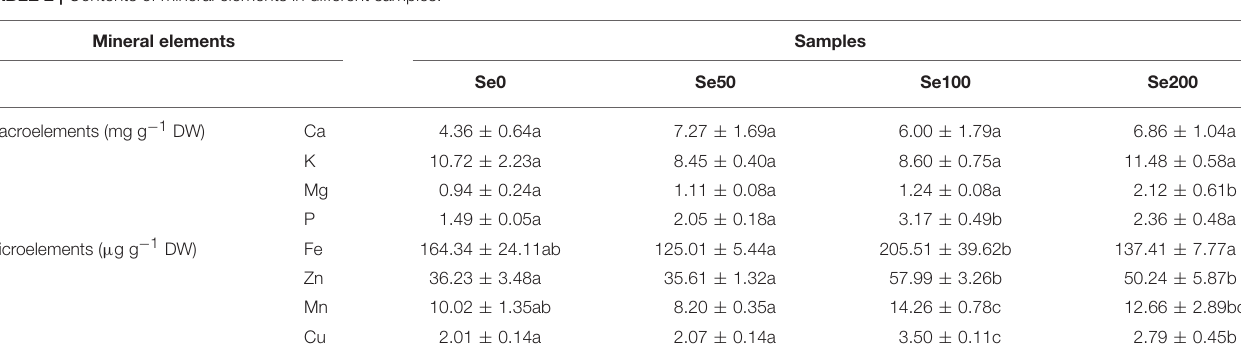
TABLE 2 | Contents of mineral elements in different